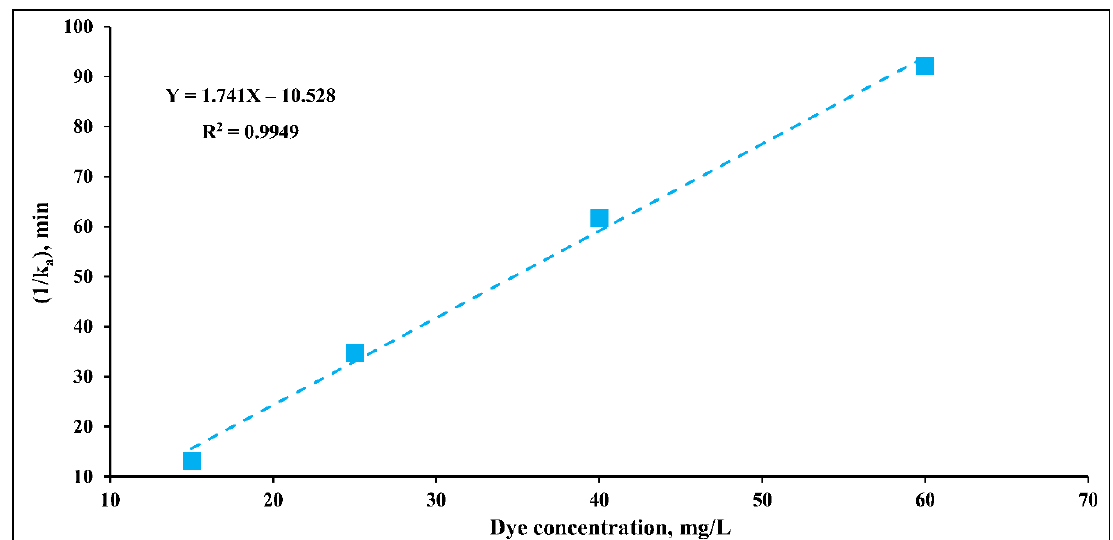
Figure 7. Influence of different dye concentrations on the k a constant of DB15 degradation at the conditions: pH 4, catalyst loading 1 g/L, and light intensity 11.2 W/m 2 .